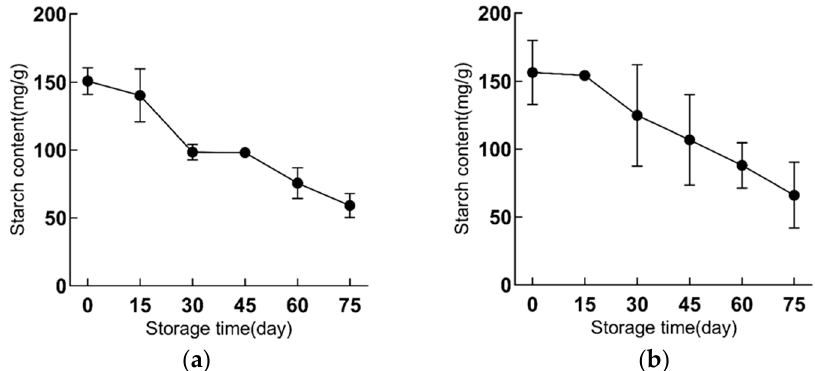
Figure 1 . The changes of starch of functional lily during cold storage. ( a ) represents ‘Fly Shaohua’, ( b ) represents ‘Fly Tiancheng’. Starch content has three biological repeats. ( b ) represents ‘Fly Tiancheng’. Starch content has three biological